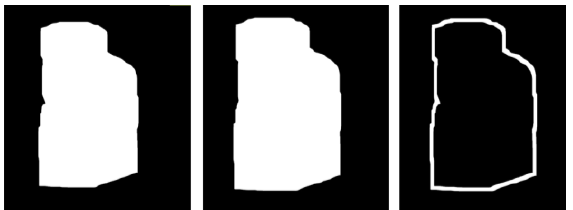
Figure 6. Seed Background Extraction using Expanding Operation.